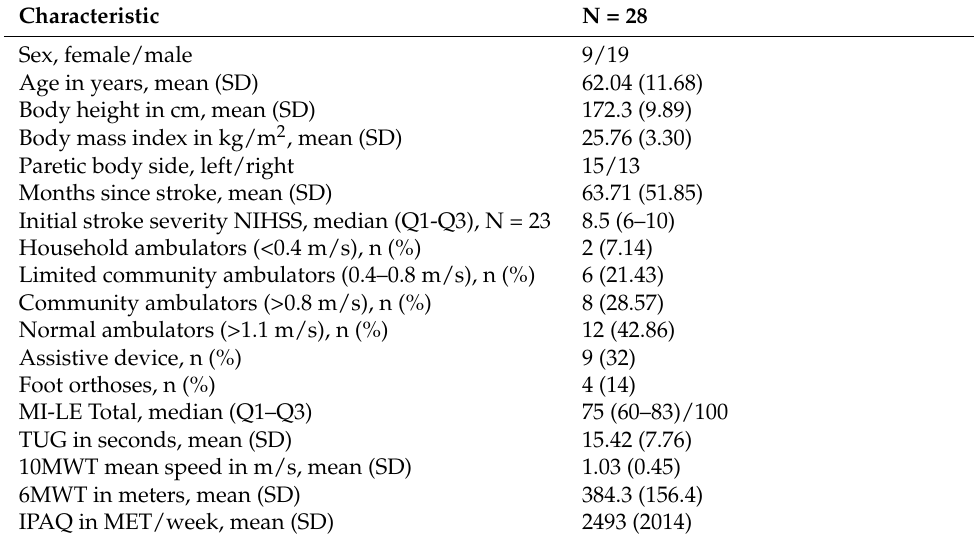
Table 1. Participant